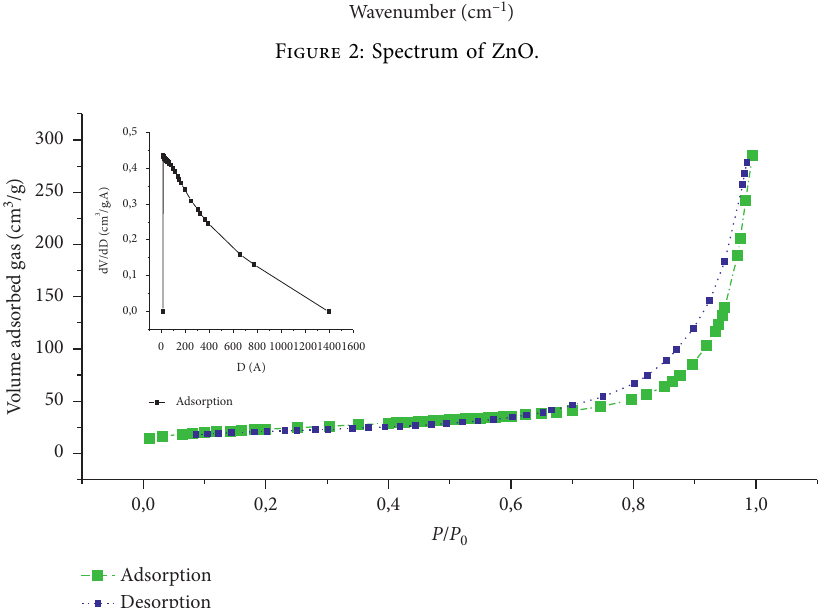
Figure 2: Spectrum of ZnO.